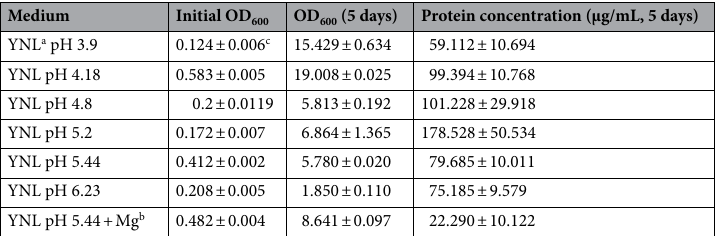
Table 1. Growth of Kluyveromyces marxianus Bot3 + 7 and protein concentrations in different culture media. a YNL indicates synthetic medium with 2% lactic acid as a carbon source. b 0.2 M MgCl medium. c The data are expressed as the mean ± standard deviation; n = 3 independent biological